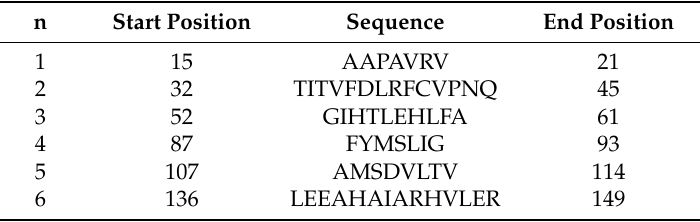
Figure 3. Signal peptides and antigenic determinants. ( A ) prediction of LuxS signal peptides by the Signal peptide server. Signal cleavage sites, internal helices, and associated motifs were not present in the sequence. ( B ) antigenicity profile and antigenic determinants of LuxS. Grey lines show the positions of six antigenic determinants within the LuxS protein. Table 1. Antigenic determinants within